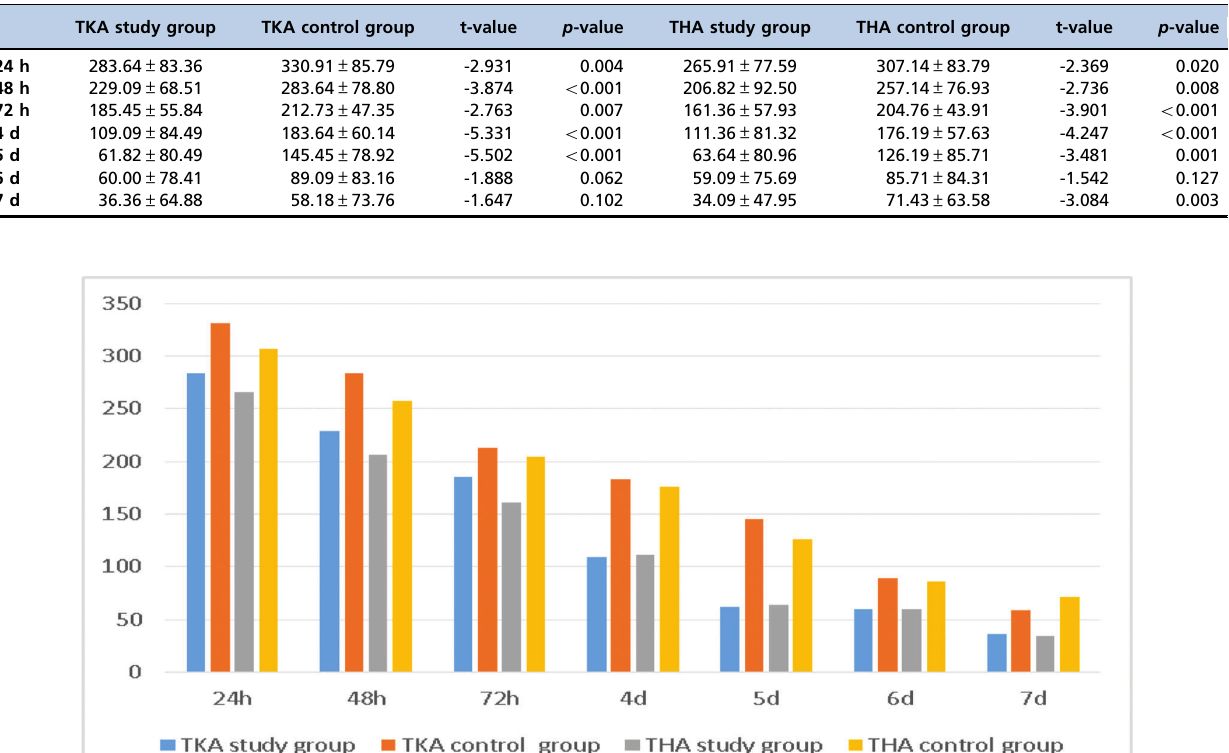
Table 5 - NSAID consumption.